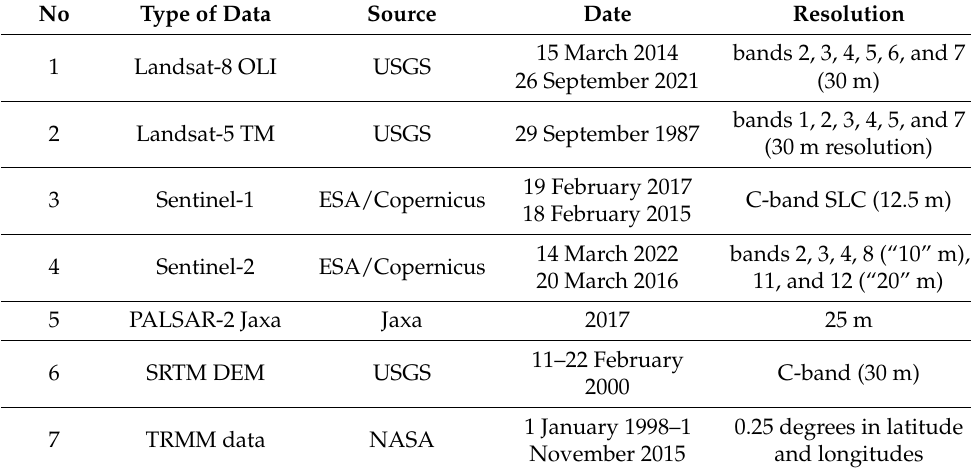
Table 1. Data used in the present